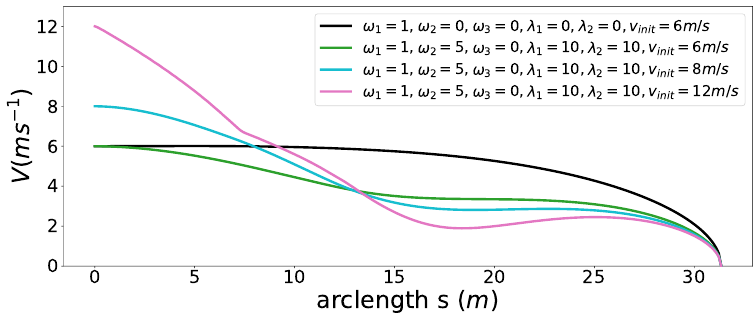
Figure 16. Speed profiles for the safe stop scenario.